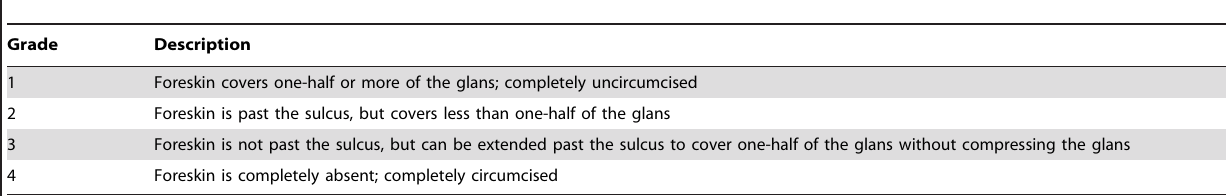
Table 1. Grading criteria for extent of male